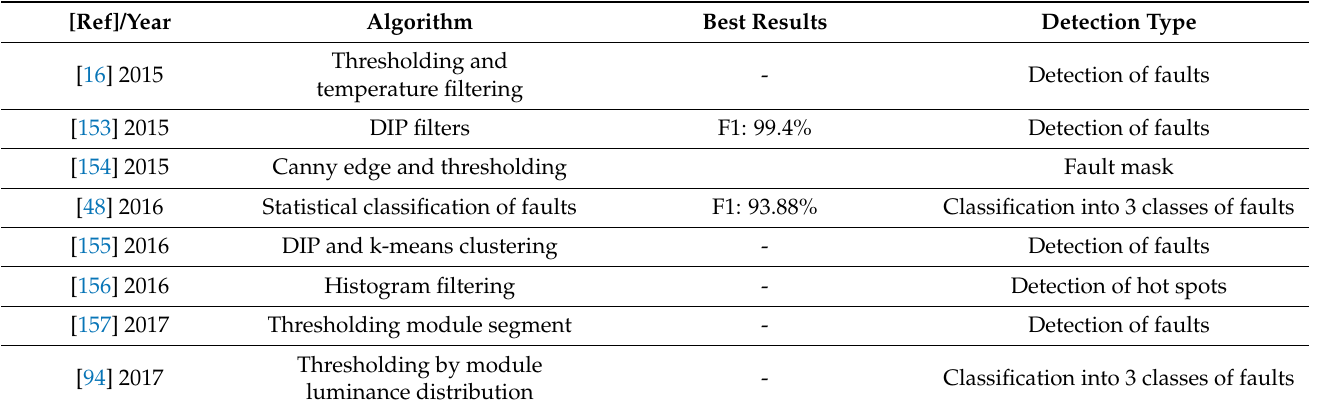
Table 6. Summary of methods for detecting PV modules in aIRT using DIP and classification